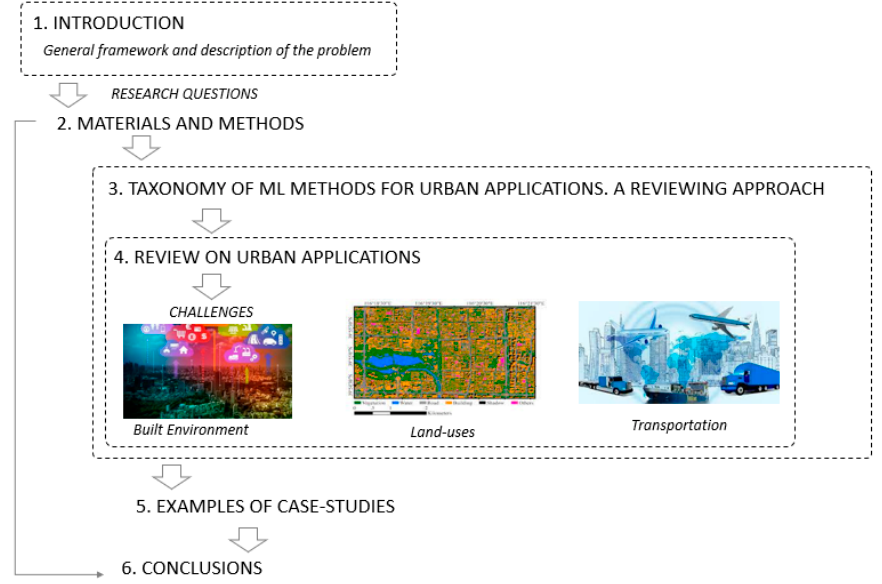
Figure 1. Paperwork plan and structure.